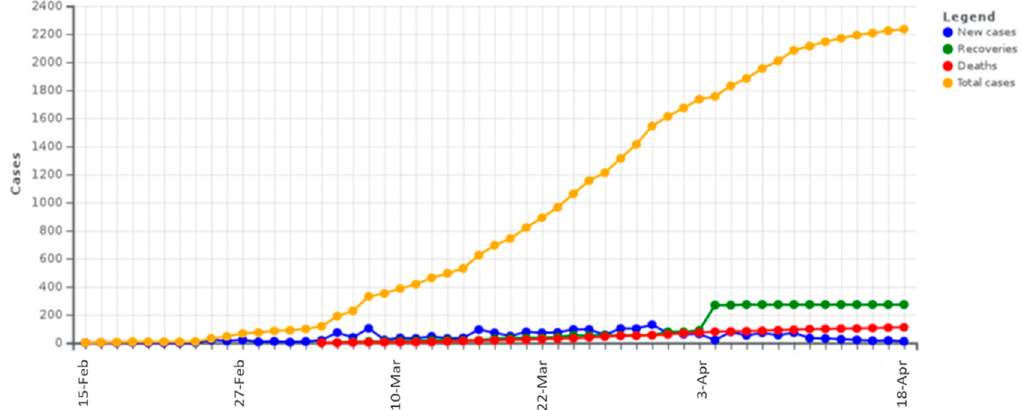
Figure 5. The aggregate time-series of the COVID-19 in Greece, showing the number of confirmed (total) cases, new infections, deaths, and recoveries, for the period 15 February 2020–18 April 2020 (data source: [15]).